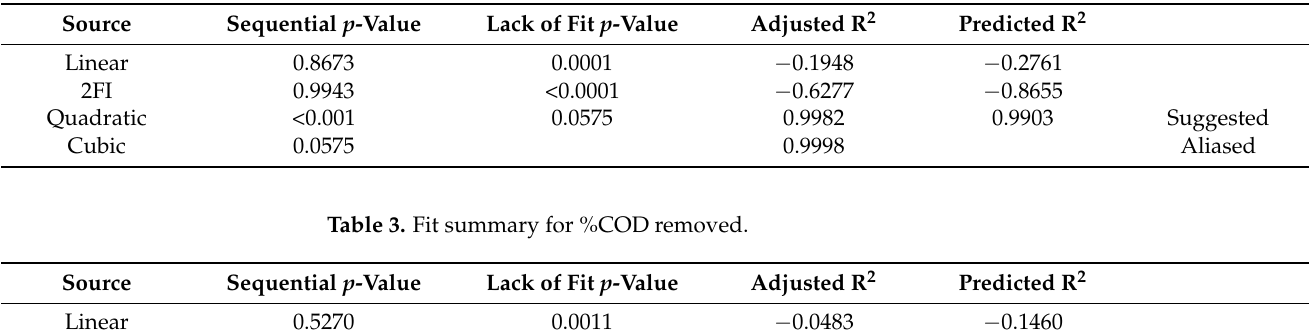
Table 2. Fit summary for biogas yield.